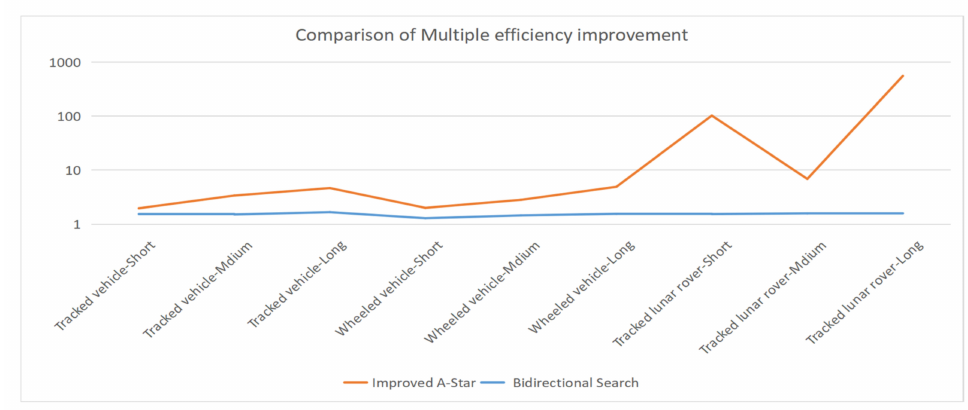
Figure 6. Comparison of multiple efficiency